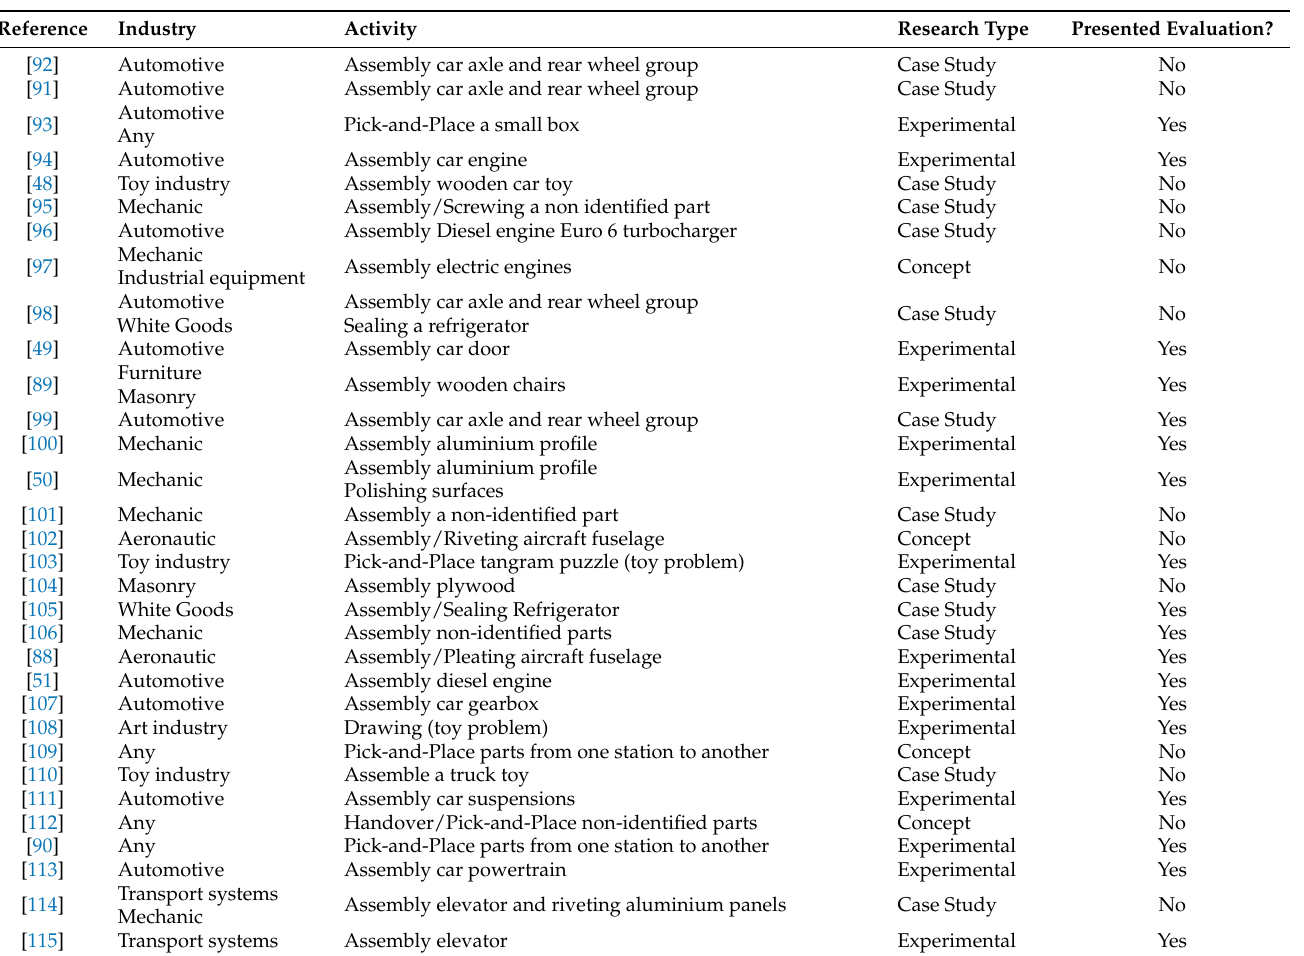
Figure 17. ( A ) Number of studies by applications; ( B ) application fields over time. Table 12. Papers’ application